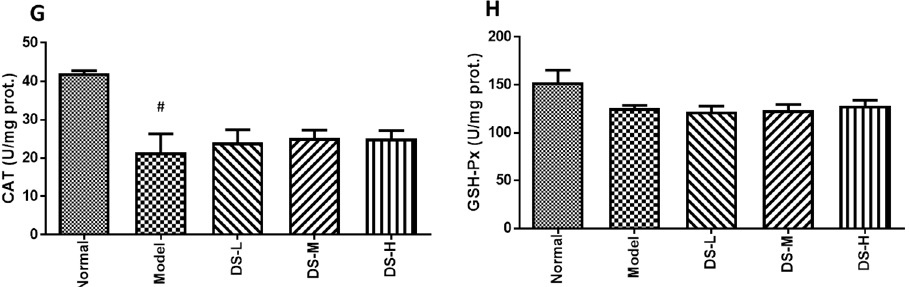
Figure 1. Liver weight to body weight ratio, body weight measurement, and biochemical assays results after Danshen treatment in acute ALD. ( A , B ) The liver weight-to-body weight radio and body weight changes; ( C ) serum ALT level; ( D ) serum AST level; ( E – H ) the production of MDA and the activity of SOD, CAT, and GSH-Px in liver tissues. DS-L for low dose of Danshen treatment group (0.093 g/kg); DS-M for middle dose of Danshen treatment group (0.28 g/kg); DS-H for high dose of Danshen treatment group (0.84 g/kg). # p < 0.05, when compared with normal group; * p < 0.05, ** p < 0.01, *** p < 0.001 when compared with model group).